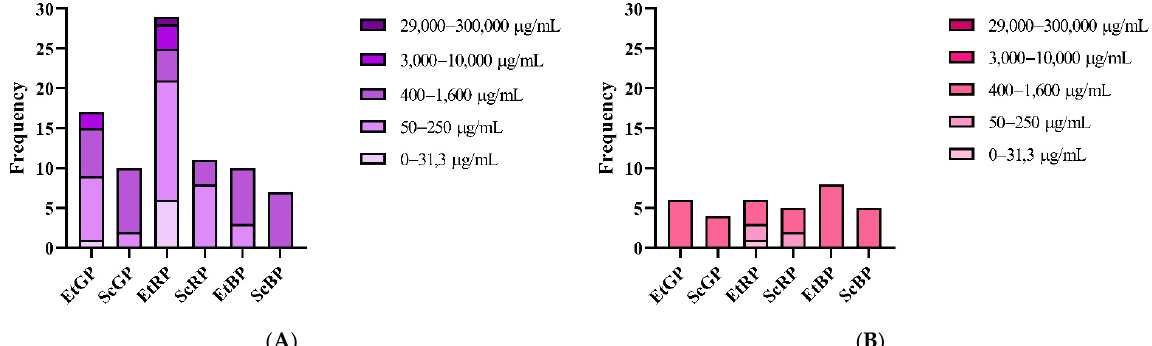
Figure 3. Antimicrobial activity of Mexican Propolis against different bacteria. ( A ) Some bacterial species are inhibited by different propolis extracts: Et, Aq, and Met. ( B ) Distribution of the minimal inhibitory concentrations (MICs) found in the 13 studies utilized. 1/10 Frequency: number of MICs found in that interval divided by 10.